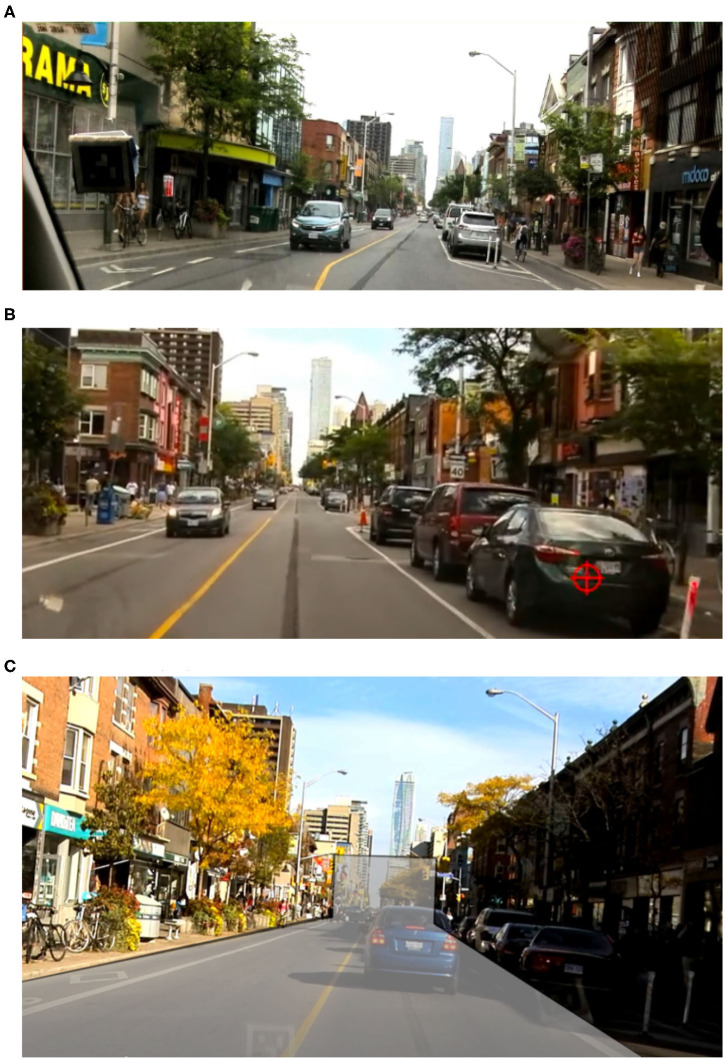
Views from the head-mounted camera on the Dikablis eye-tracker used for glance analysis. (A) Snapshot of Bloor St. (B) Gaze position indicated by the red cross-hair. (C) Bounded region considered “on-road”.